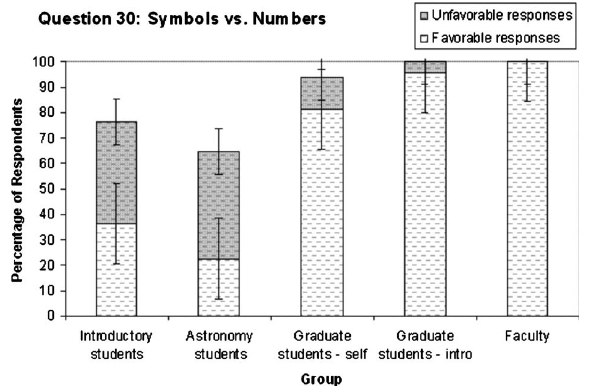
FIG. 6. Histogram showing favorable (cid:1) disagree (cid:2) and unfavor- able (cid:1) agree (cid:2) responses for survey question (cid:1) 30 (cid:2) . The histogram shows that faculty and graduate students did not believe that it is more difficult to solve a physics problem with symbols than solving an identical problem with numerical answer but introductory phys- ics and astronomy students often did.